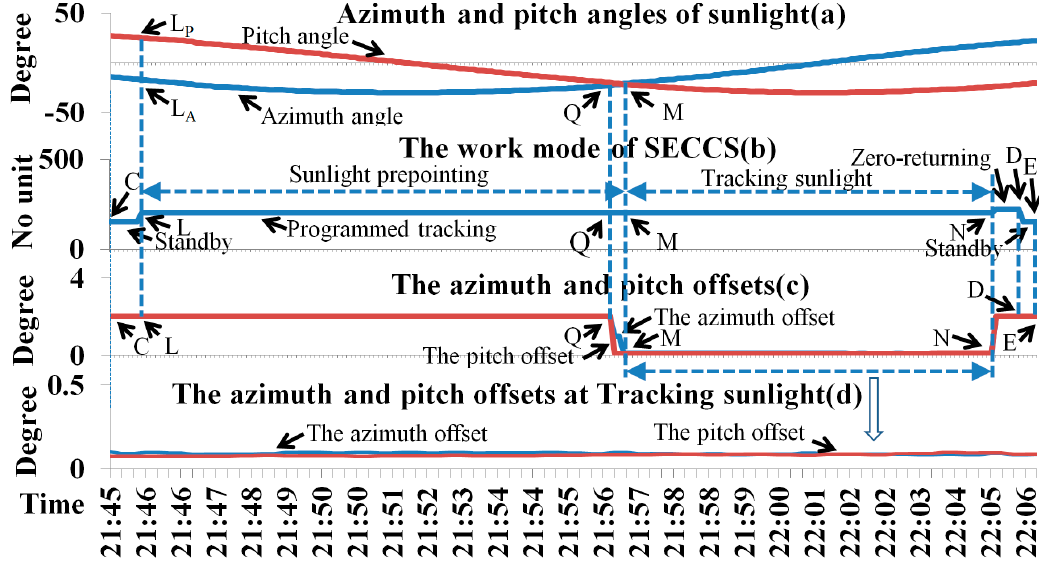
Figure 7. The work mode and angle in the second orbit using the alternative method.